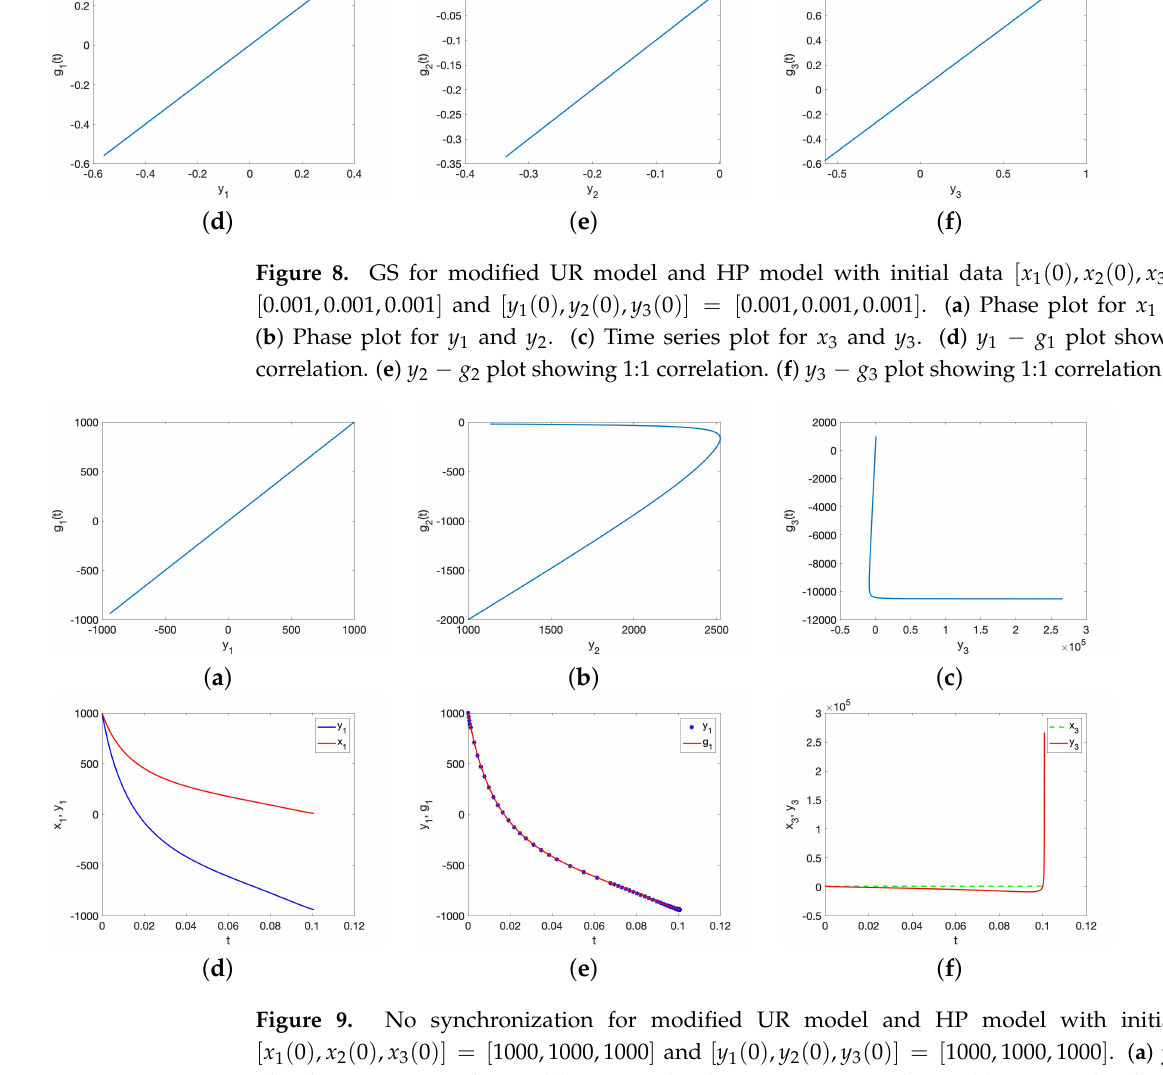
( 0 ) , y ( 0 ) , y ( 0 )] = [ 1000,1000,1000 ] . ( a ) y 2 3 1